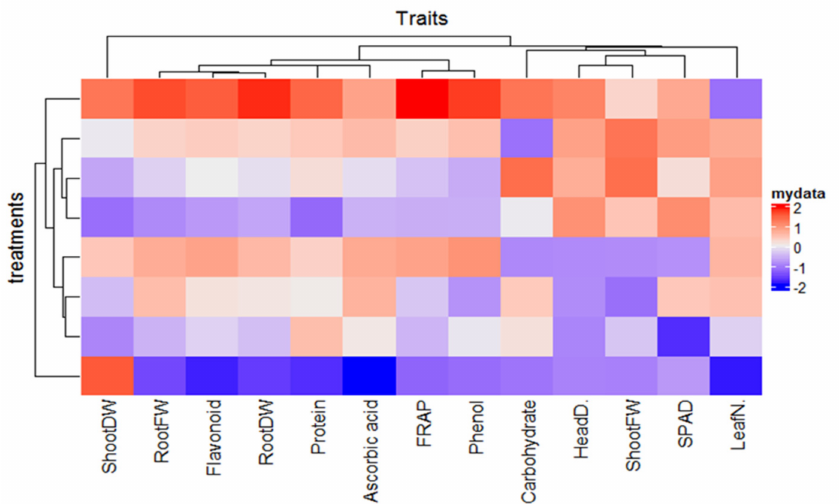
Figure 6. The morphological and biochemical changes in lettuce plants treated with arbuscular mycorrhiza (AMF) and seaweed extract (SWE). Heat map representing head DW (dry weight), root FW (fresh weight), flavonoid (total flavonoids content), root DW, protein (total proteins content), TAA (total antioxidants activity by FRAP method), phenol (total phenolics content), carbohydrates content, head D (head diameter), head FW, SPAD (chlorophyll index) and leaf N (leaf